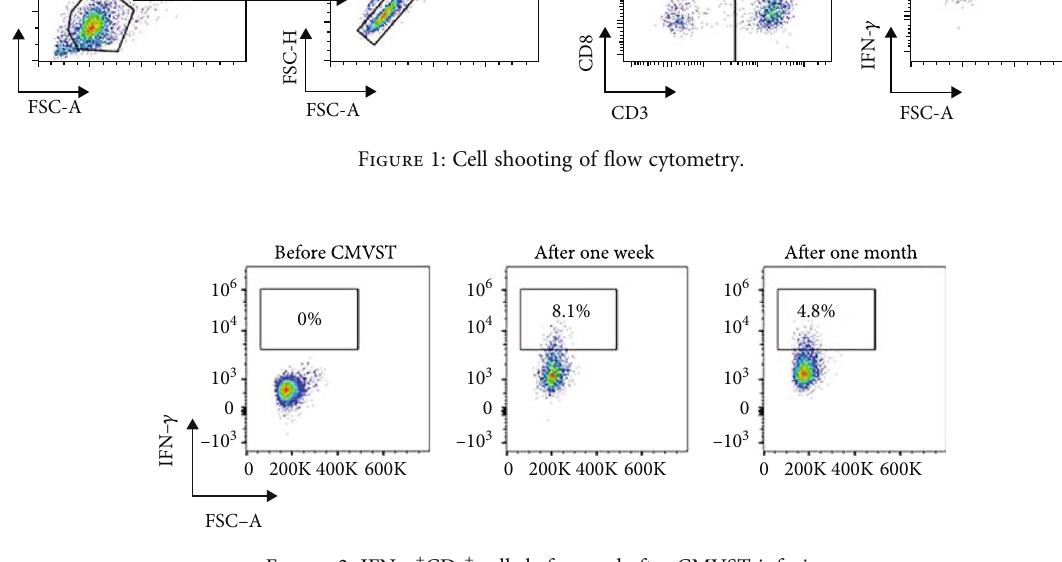
Figure 2: IFN- γ + CD 8+ cells before and after CMVST